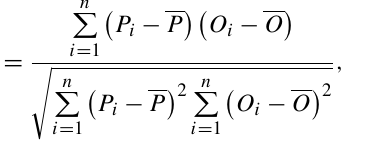
(November–February) and summer months